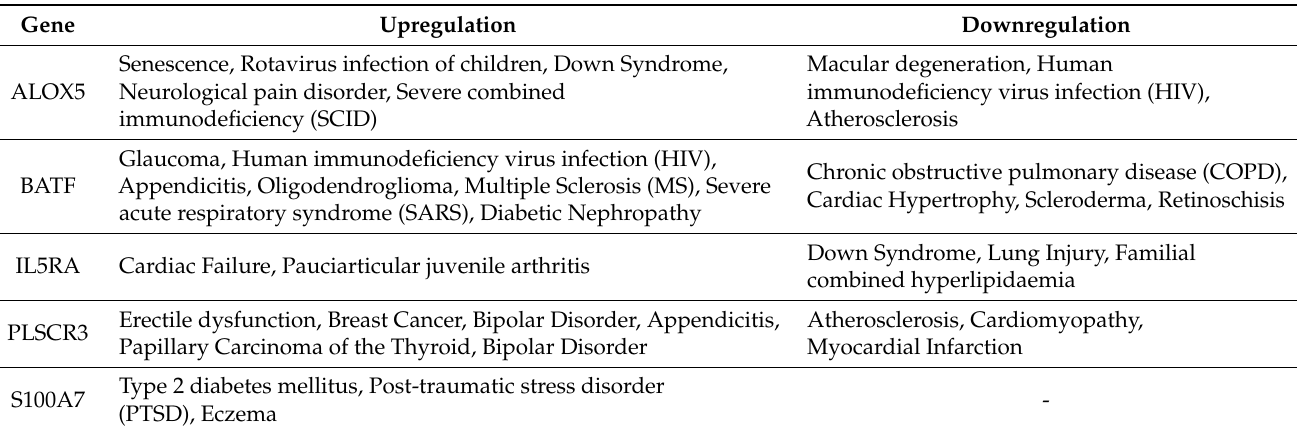
Macular degeneration, Human immunodeficiency virus infection (HIV), Atherosclerosis Chronic obstructive pulmonary disease (COPD), Down Syndrome, Lung Injury, Familial combined hyperlipidaemia